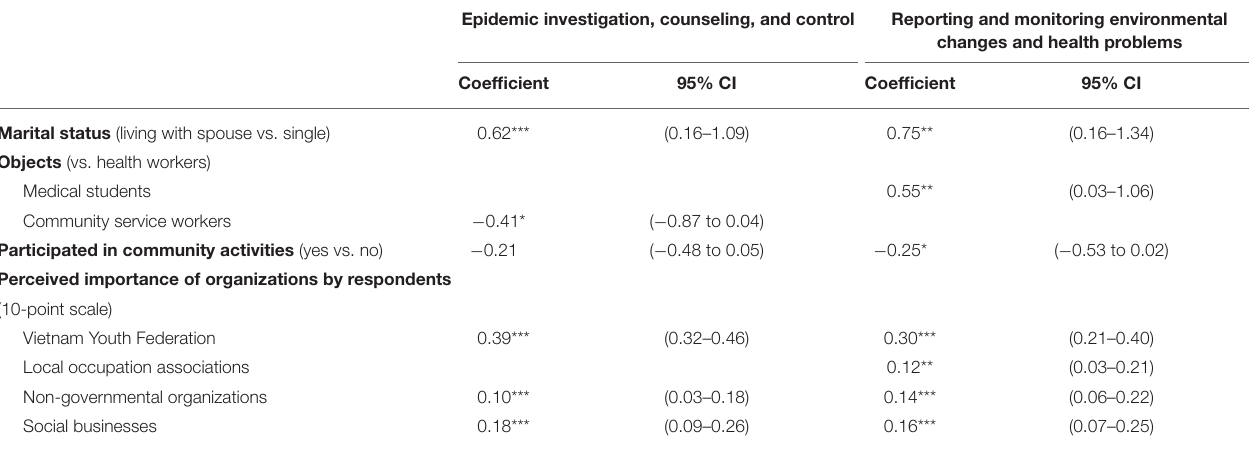
TABLE 5 | Factors associated with perceived efficiency of involving community service workers in health care–related activities at grassroots